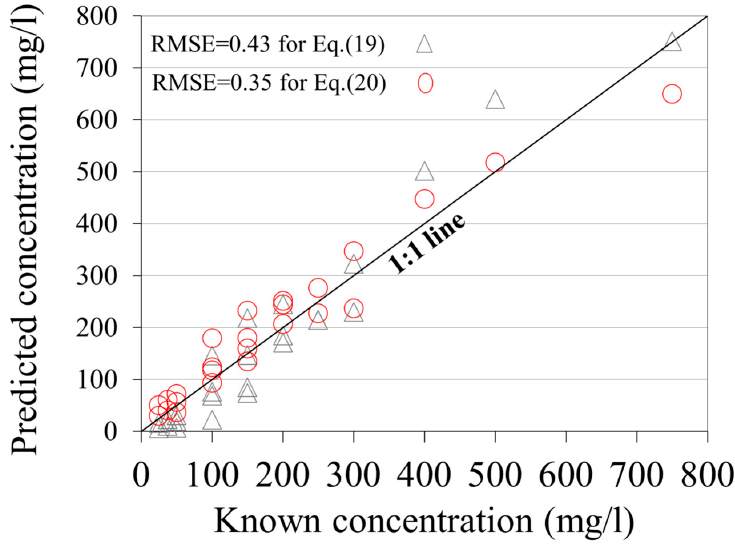
Figure 8. Predicted vs. known concentrations for the well-sorted beach sand fractions from Folly Island, South Carolina, with predictions computed using Equations (19) and (20).